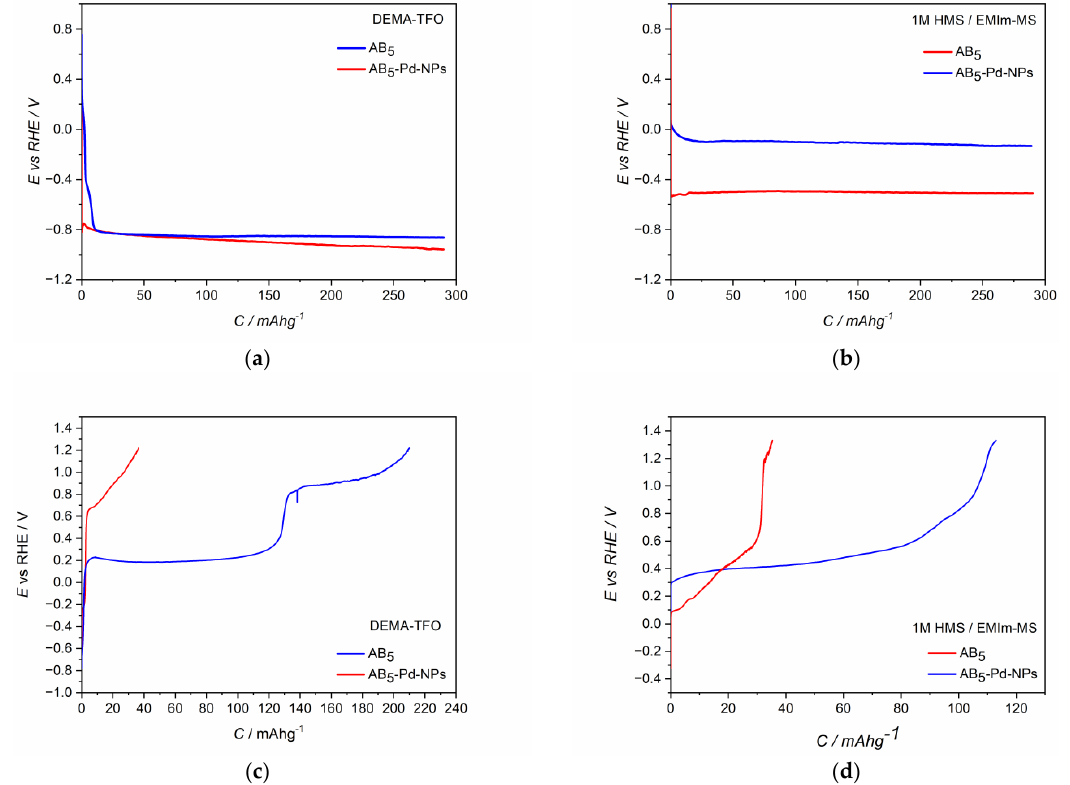
Figure 4. Charge ( a , b ) and discharge ( c , d ) potential profiles of electrodes in ( a , c ) DEMA-TFO; ( b , d ) 1 M HMS/EMIm-MS; Blue line — AB 5 -Pd-NPs; red line — AB 5.